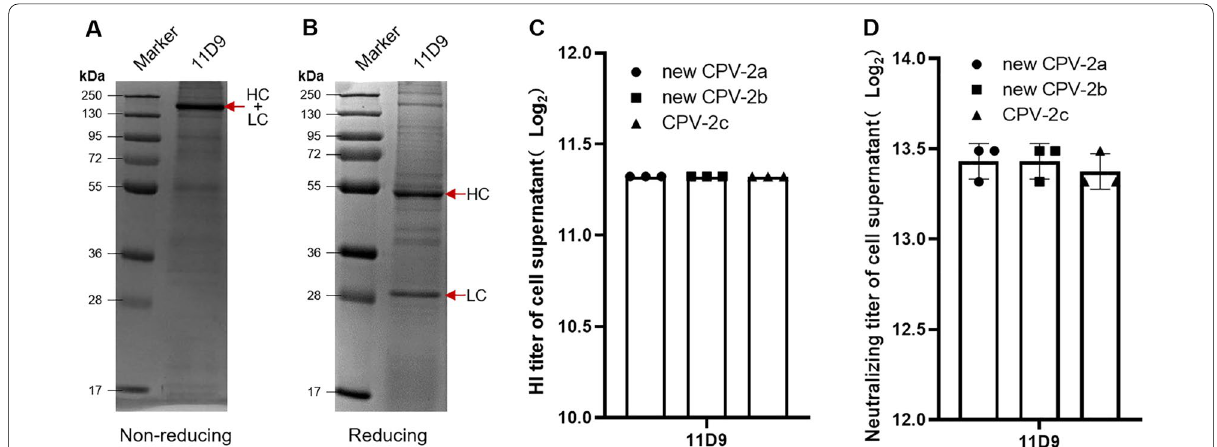
Fig. 6 Antibody identification of 11D9. A Non-reducing SDS-PAGE of 11D9; B Reducing SDS-PAGE of 11D9; C and D The HI and neutralization titers of 11D9 to new CPV-2a, new CPV-2b, and